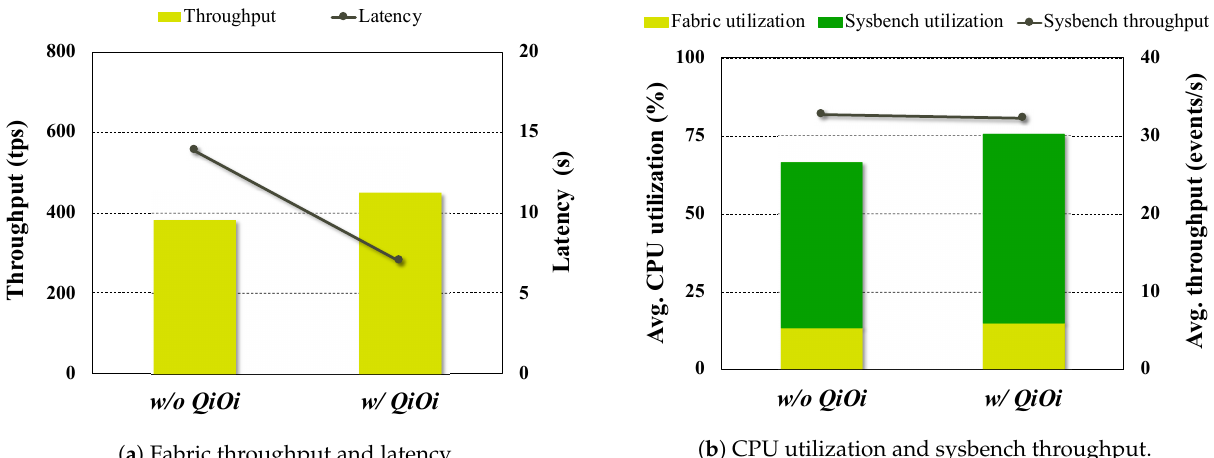
Figure 11. Impact of QiOi on Fabric using marbles